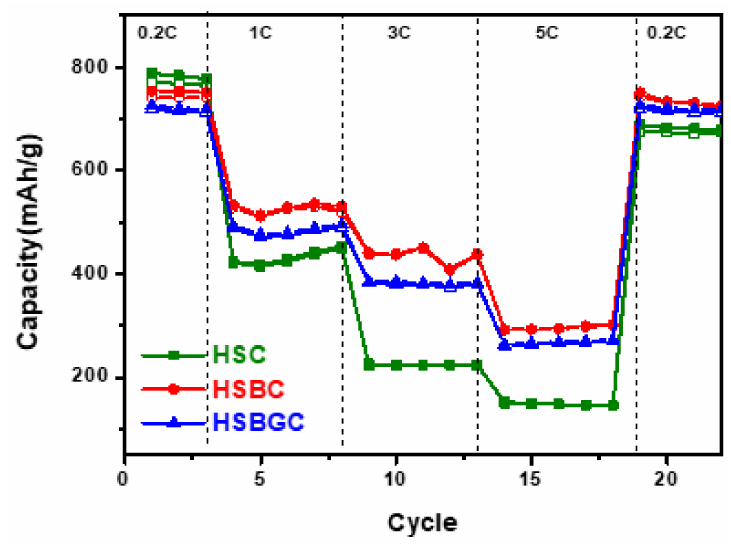
Figure 10. Charge rate performance of HSC, HSBC, and HSBGC